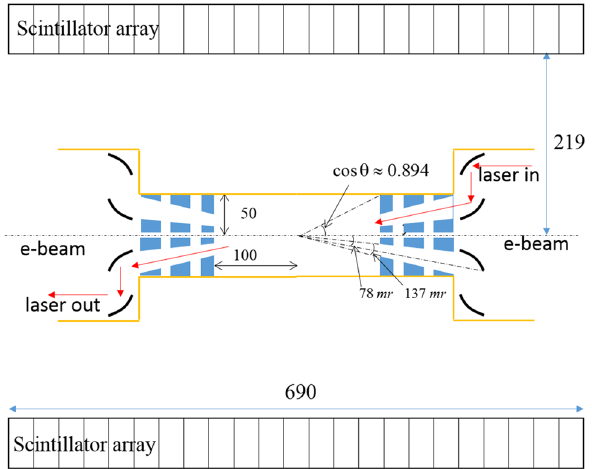
Fig. 4 Cross-sectional view of the detector model. The detector is a scintillator array made of CsI and plastic scintillator. The final focus magnet of the radius of 50 mm is placed 100 mm from the interaction point. The laser pass (only one of the two) is indicated by